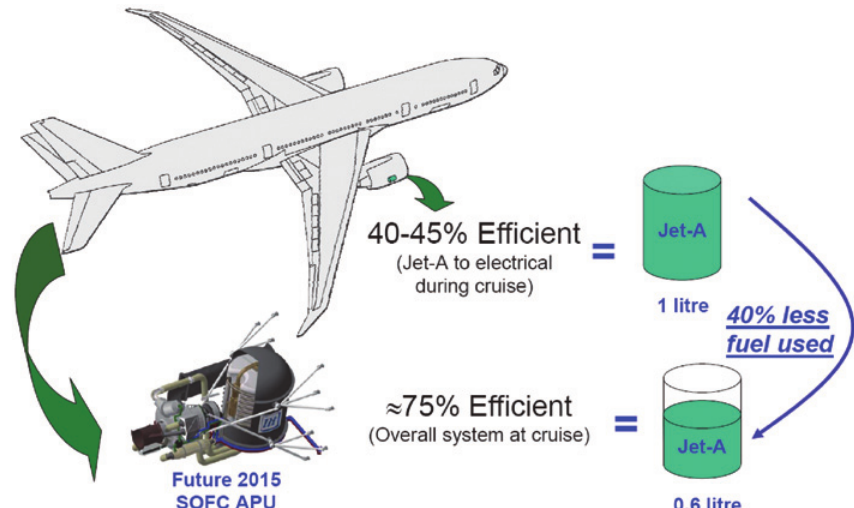
Fig. 7. Boeing – fuel saving during